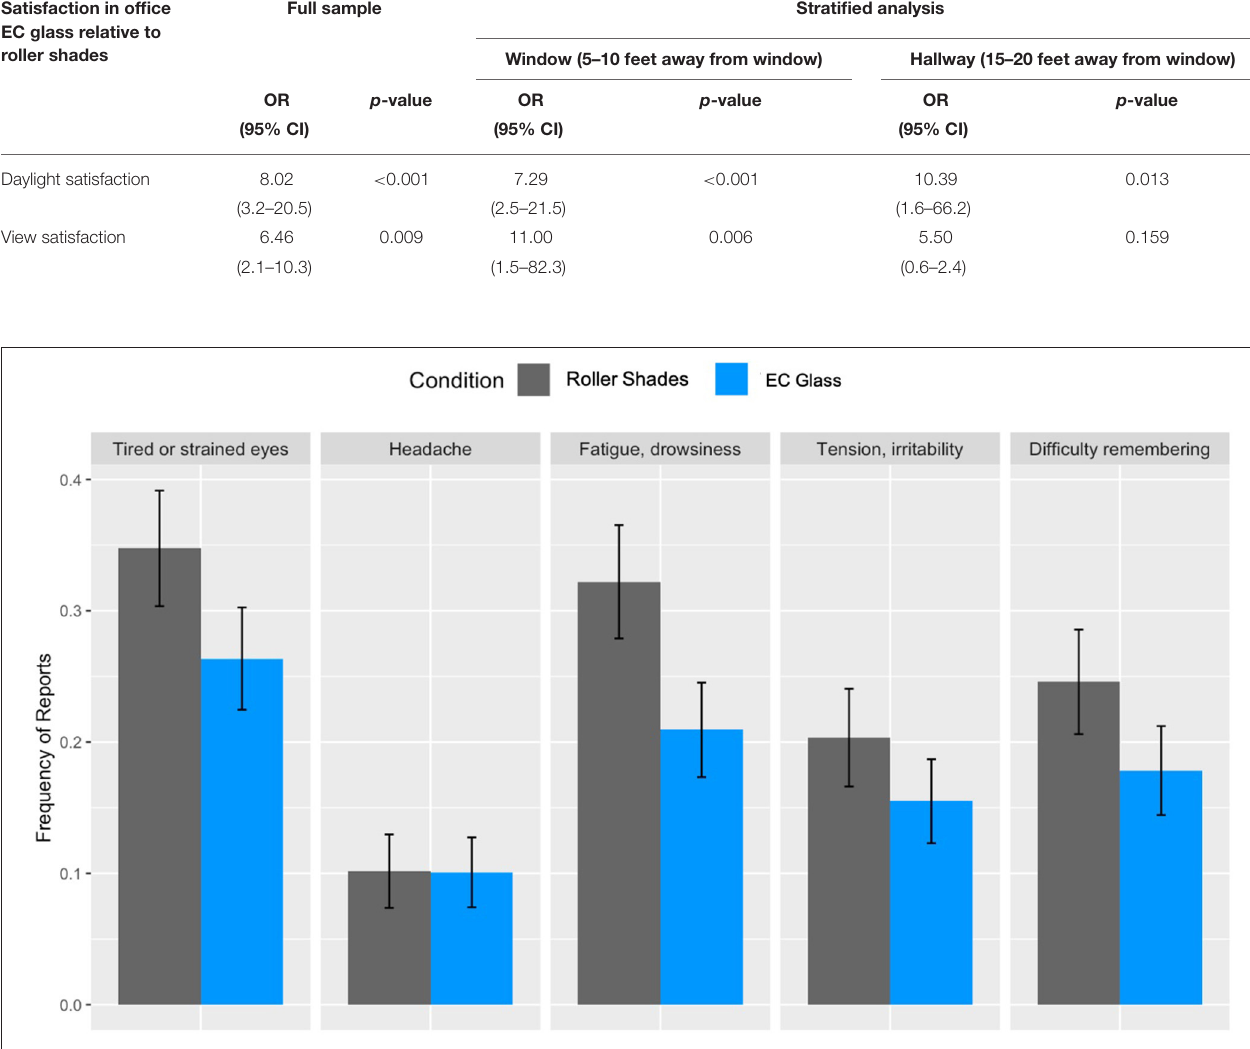
FIGURE 4 | Frequency of reporting physical health symptoms while working in the Roller Shades and EC Glass offices. Error bars depict standard